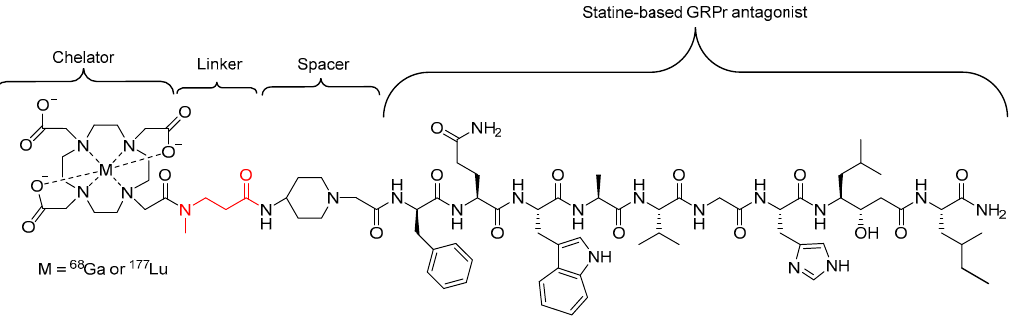
Figure 11. Statine-based GRPr antagonist radiopharmaceutical investigated by Popp et al., with the N -methylated β -alanine linker highlighted in red [82].